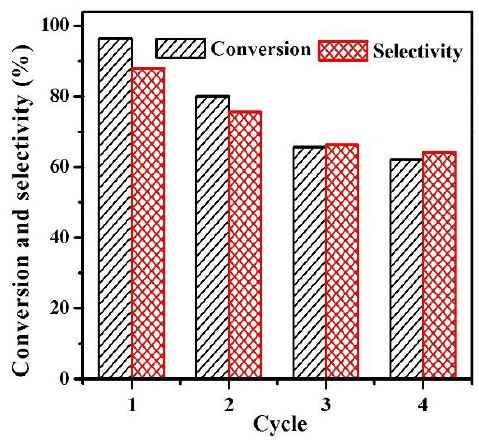
Figure 7. Stability test for 0.2%Pd-1.2%Ni/SBA-15 (Reaction conditions: 12.5 mg catalyst, 250 mg CAL, 15 mL isopropanol, 80 °C, 2 h, 12 bar H 2 ).